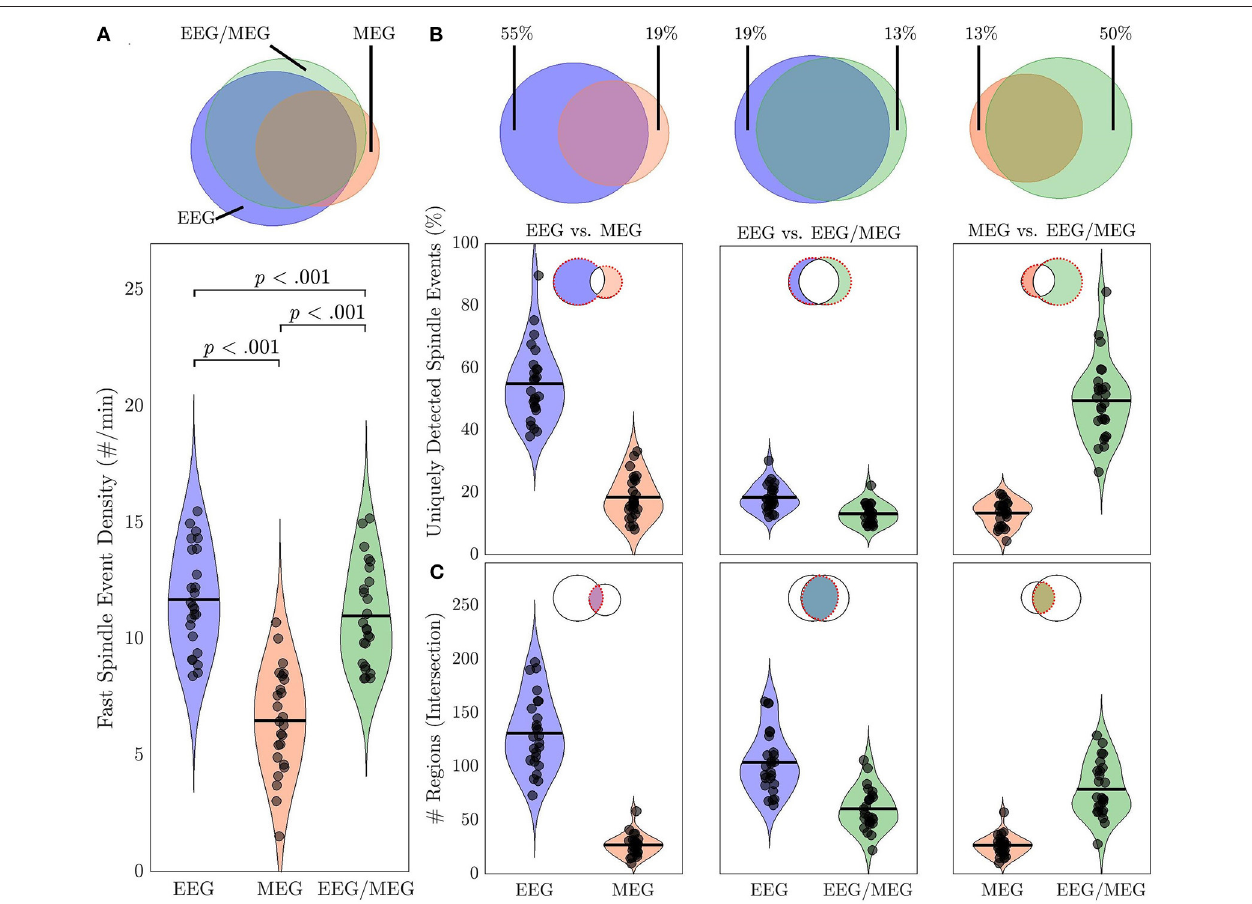
FIGURE 6 | Spindle events in source space using EEG alone, MEG alone and combined EEG/MEG. (A) Venn diagram and violin plots depicting spindle event density in EEG, MEG, and EEG/MEG with p -values for pairwise comparisons. (B) Percent of uniquely detected spindle events by each modality for EEG vs. MEG, EEG vs. EEG/MEG, and MEG vs. EEG/MEG. (C) Spatial specificity of commonly detected spindle events (intersection of Venn diagrams). Spatial extent of spindle events detected by EEG and MEG, EEG and EEG/MEG, and MEG and EEG/MEG. Black circles represent individual